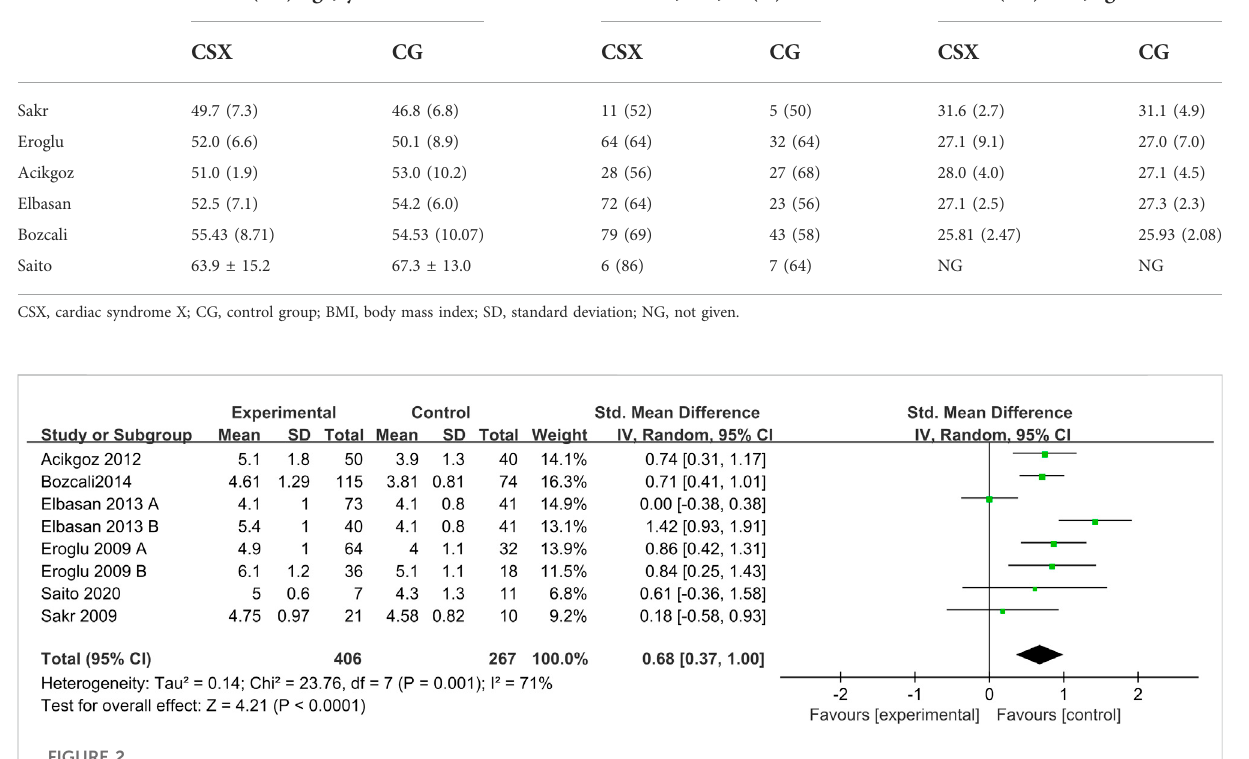
FIGURE 2 Forest plot for the connection between CSX and UA